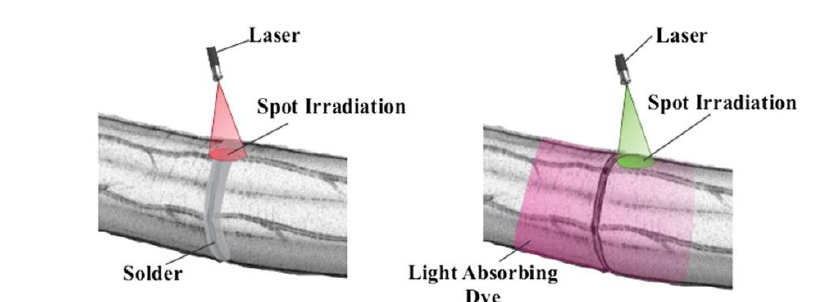
Figure 4. Schematics of laser welding of a nervous tissue, with the application of a solder and a light absorbing dye [40].